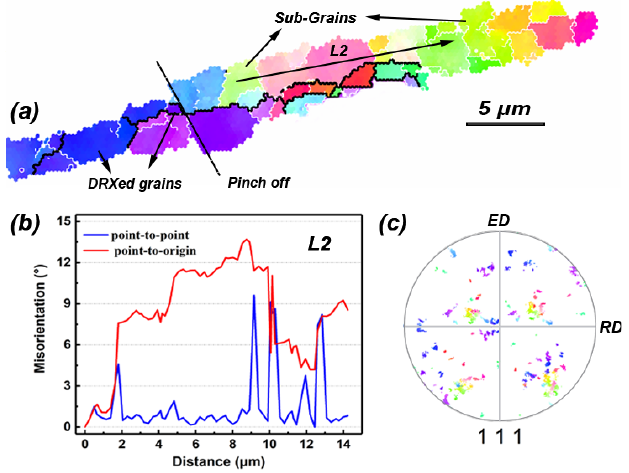
Figure 16. The DRX behavior of the deformed region (A4) selected in Figure 14h: ( a ) IPF coloring map, ( b ) line profile of MA along the line L2 in ( a ), and corresponding ( c ) (111) pole figure and ( d ) inverse pole figure.